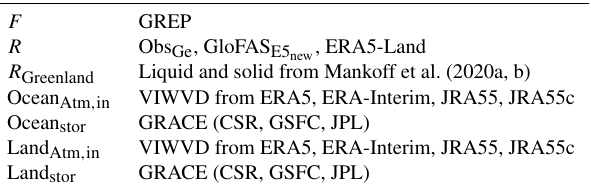
Table 9. List of employed data sets in the variational adjustment procedure.